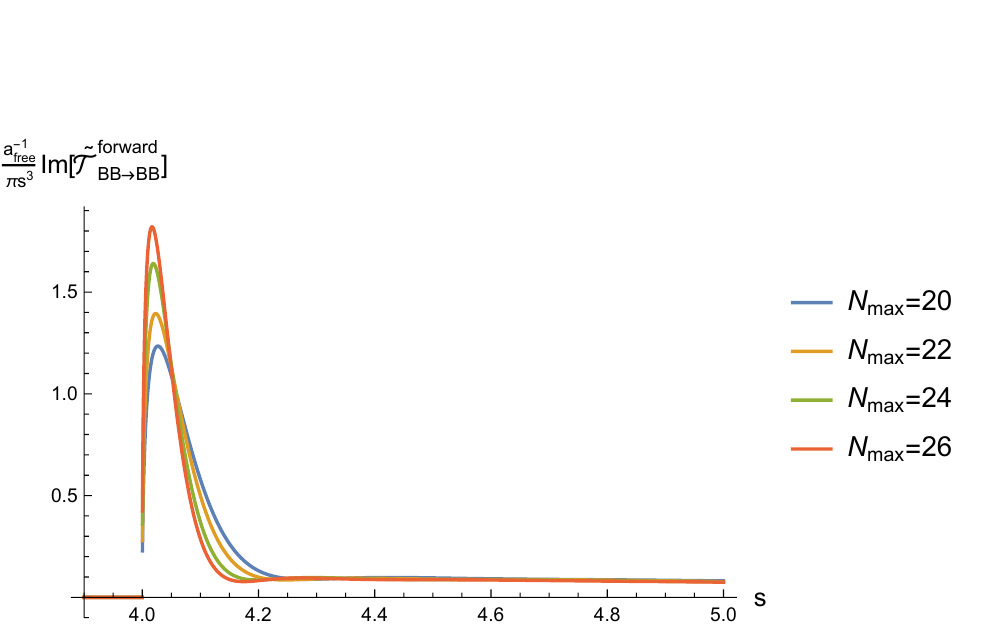
Figure 9 . Integrand appearing in the sum-rule (3.57) for the absolute minimum of the a -anomaly. Different colors indicate different values of N max . Numerical integration of these function leads to a/a free = 0 . 4146 , 0 . 4058 , 0 . 4001 and 0 . 3896 in a perfect agreement with (5.14).